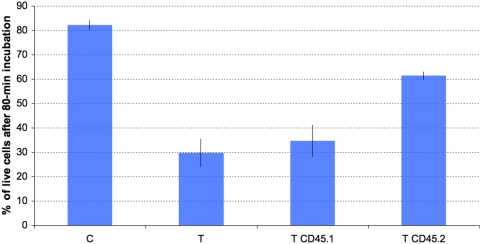
Mouse splenocyte survival upon exposure to the trypanosomal non-cytosolic fraction is increased by anti-CD45.2 but not by anti-CD45.1 mAb.Splenocytes were from C57BL/6 mice, which are homozygous for the CD45.2 genotype. C, mock-exposed splenocytes; T, T CD45.1 and T CD45.2, splenocytes exposed to the trypanosomal non-cytosolic fraction after preconditioning with either PBS, anti-CD45.1, or anti-CD45.2 mAb (15 µg/5.105 cells) respectively. Values are relative fractions of annexinV/PI-double-negative (healthy) splenocytes after an 80-min exposure, as determined by flow cytometry. Values are means±SD of three independent experiments. Asterisks show values significantly different from T values (P<0.05).